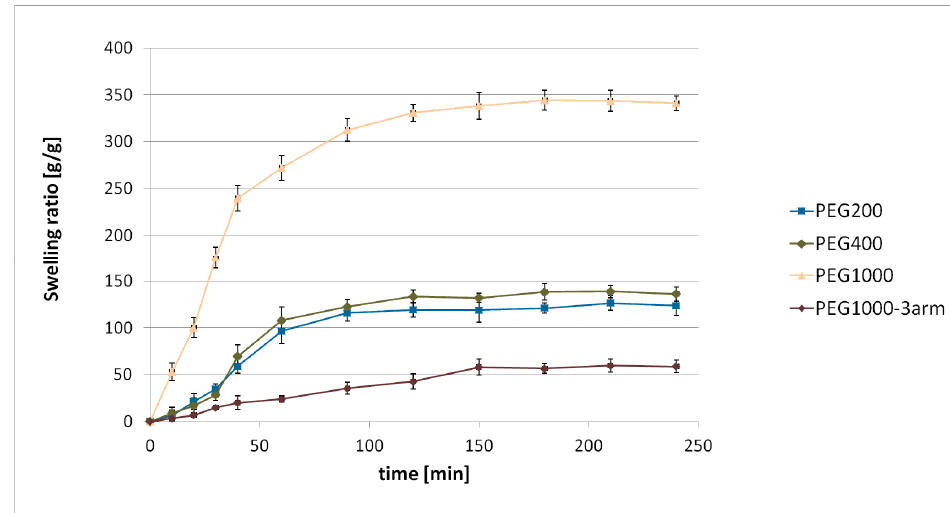
Figure 4. Swelling behaviour of γ -PGA-based hydrogels in deionised water as function of time ( n = 3, error bars, standard deviation).